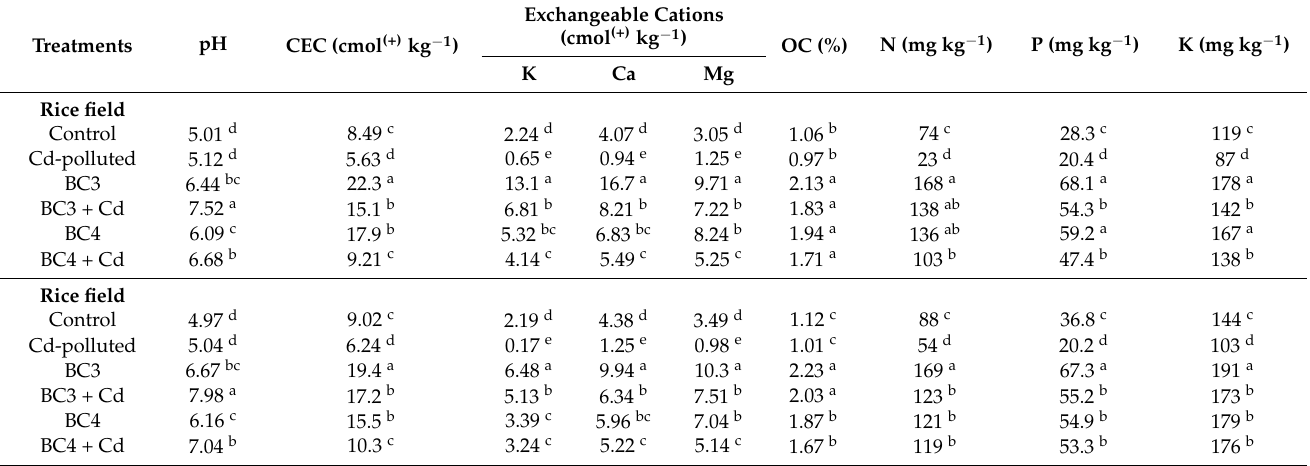
Table 1. Chemical properties of soil as affected by treatments after four months (end of